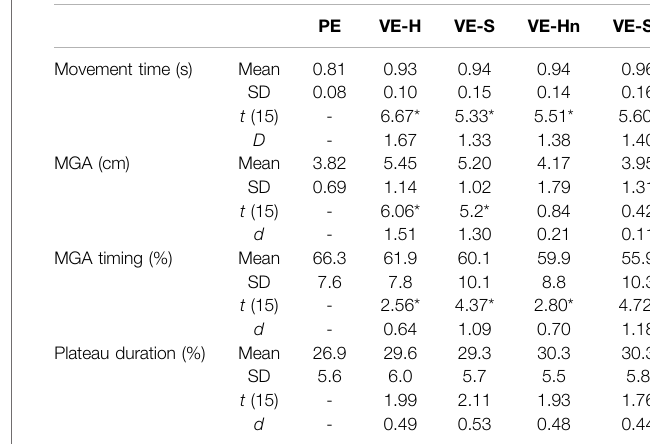
TABLE 1 | Kinematic measures of reach-to-grasp